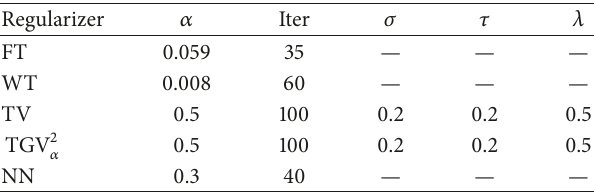
Table 1: FISTA parameters. Table 2: Mean SER and CCC across all sampling